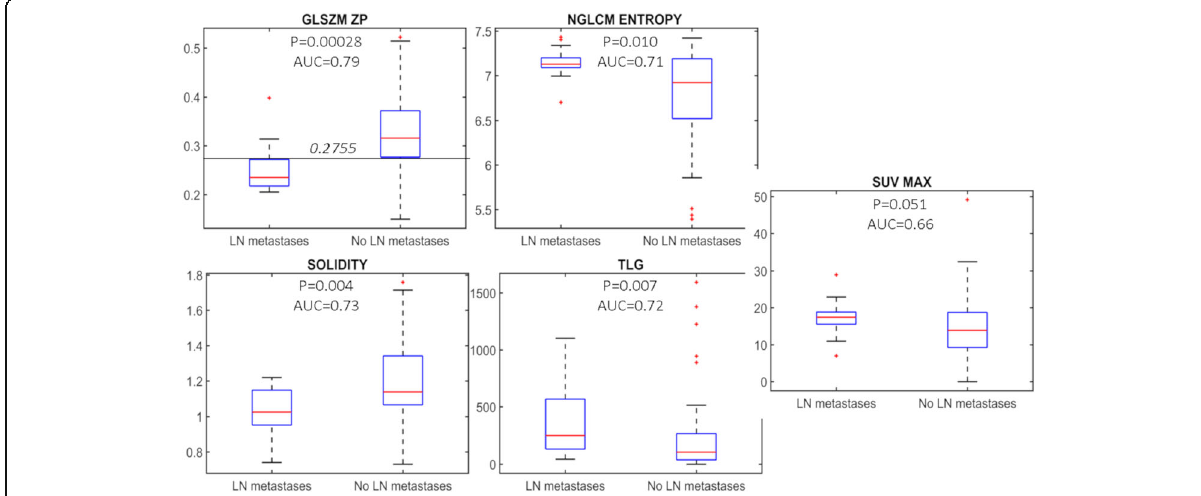
Fig. 3 Boxplot representation of the four features selected after feature reduction to classify patients with and without LN metastases. P values of univariate test and AUC values are reported. SUVmax distribution is added for